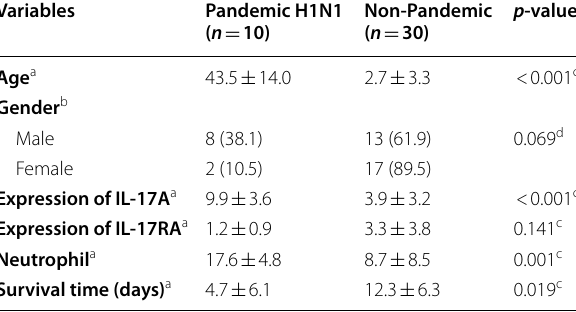
Table 1 Baseline and Immunohistochemistry characteristics